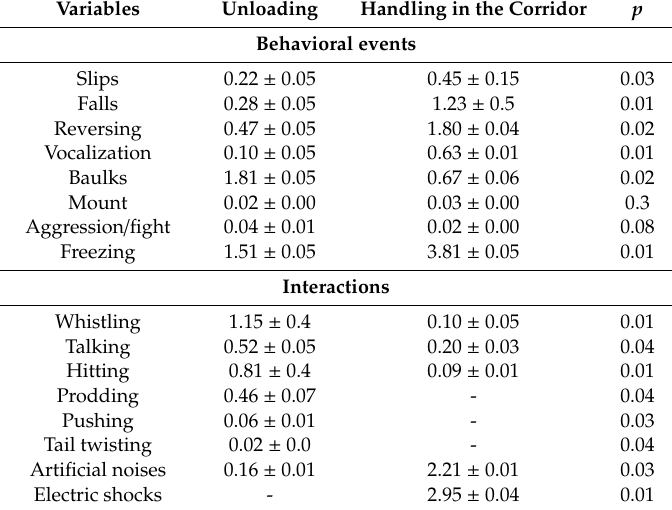
Table 3. Least square means ( ± SE) of interactions of stockperson (per minute) and individual behavioral events of dairy cull cows (per minute) observed during unloading and handling in the corridor at the